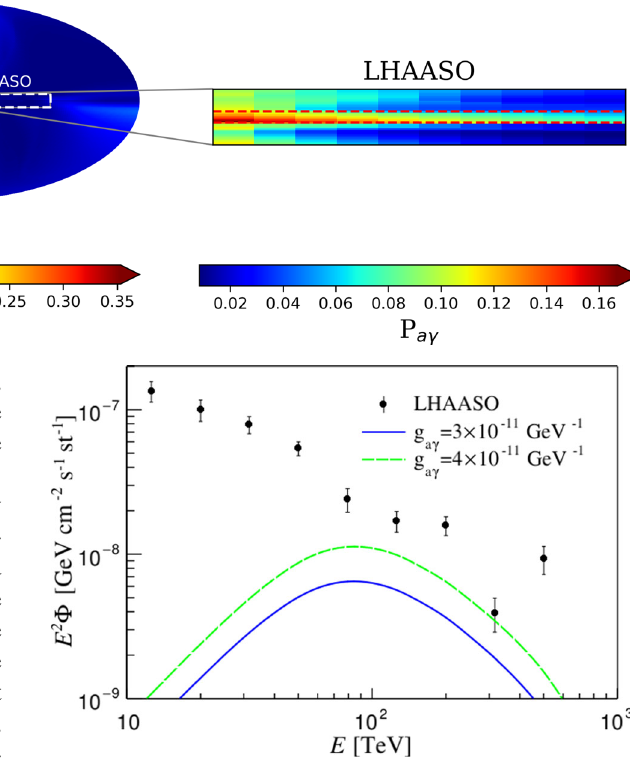
Fig. 9 Expected photon flux from ALP conversions. We assume the box model of the host galaxy B field with B T = 5 × 10 − 6 G and the Fiducial case of Table 1 for the photon spectrum in source. We show cases with g a γ = 3 × 10 − 11 GeV − 1 (blue continuous line) and g a γ = 4 × 10 − 11 GeV − 1 (green dashed line). LHAASO data points are also